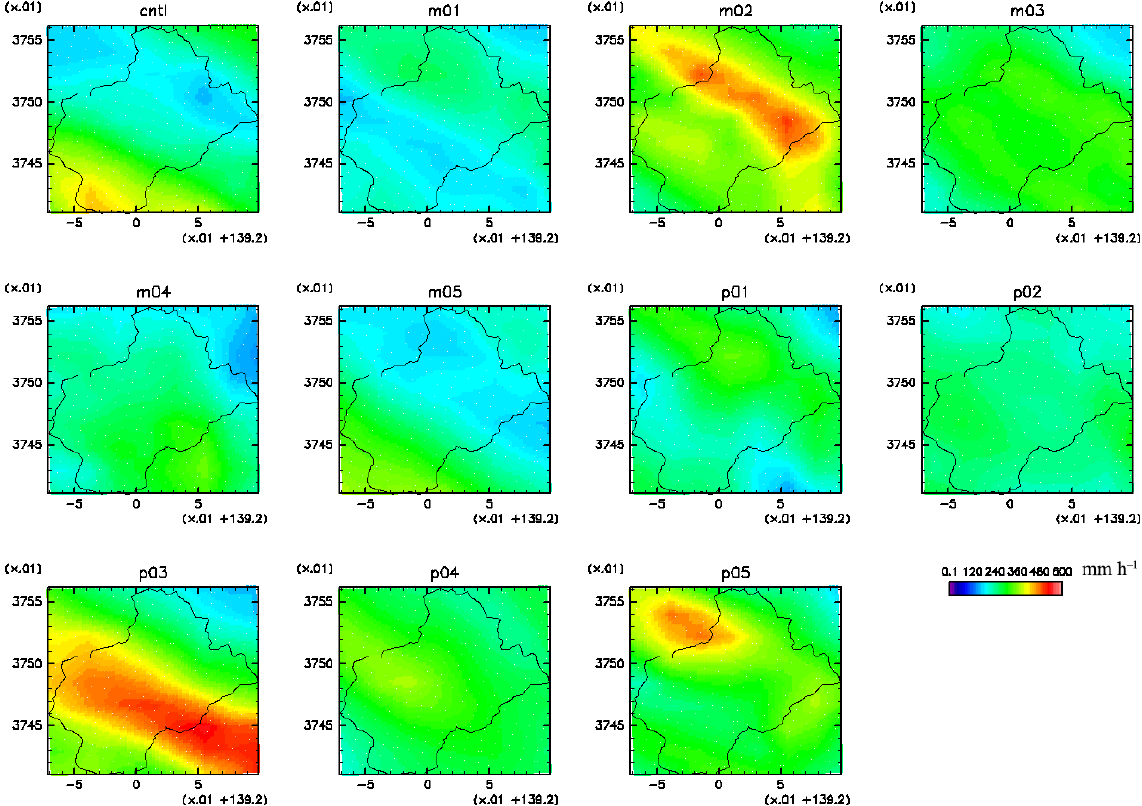
Figure 17. Spatial distributions of cumulative ensemble rainfalls with position shift (2km